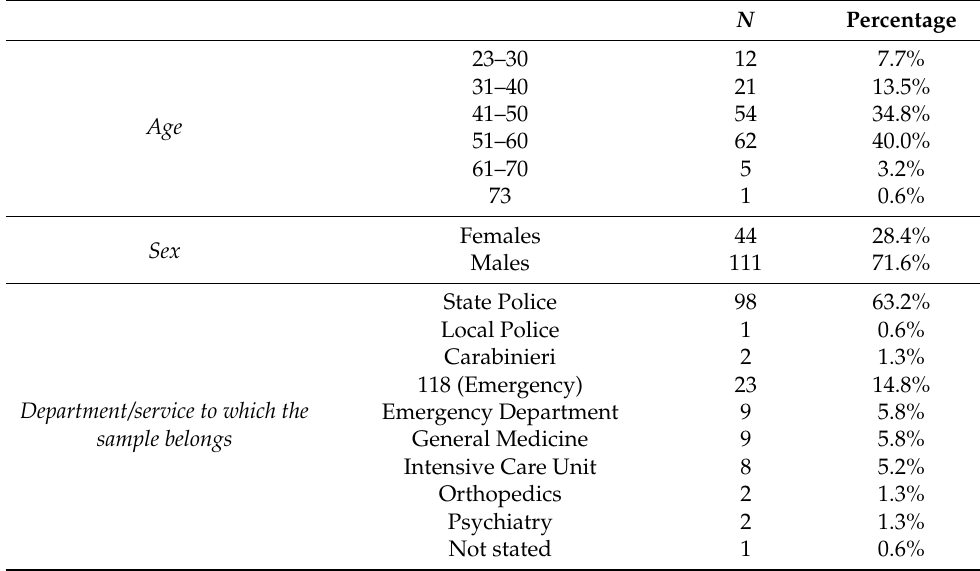
Table 2. Age, gender and department/service to which the sample